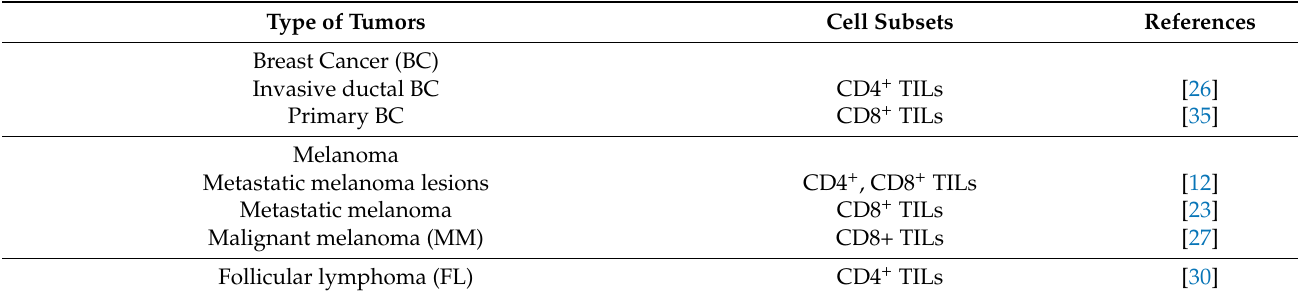
Table 1. Evidence reporting PD-1 expression on human T, NK and ILC cells in different cancers. For each data tumor type, cell subset and reference have been reported. PB: peripheral blood; PE: Plural effusion; TILs: tumor-infiltrating lymphocytes; DLBCL: diffuse large B-cell lymphoma; ADC: Adenocarcinoma; NSCLC: non small cell lung cancer; SCC: squamous cell